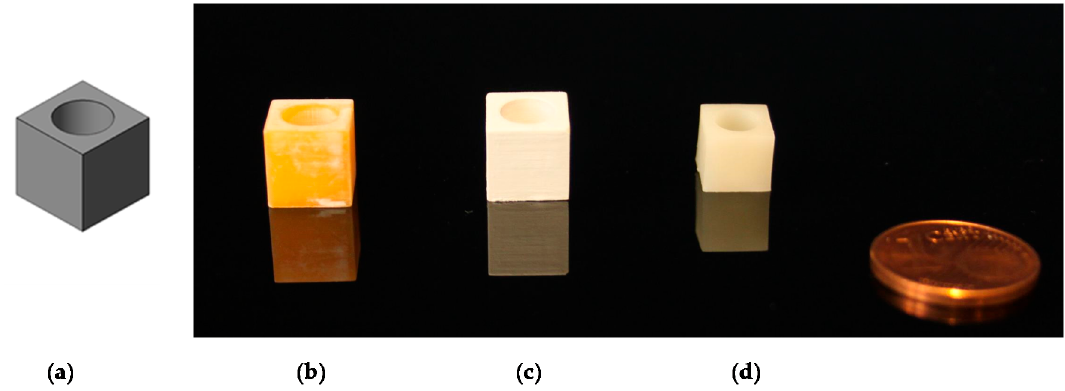
Figure 6. Scaling cubes: ( a) stl file; ( b ) green body; ( c ) debinded body; ( d ) sintered body.